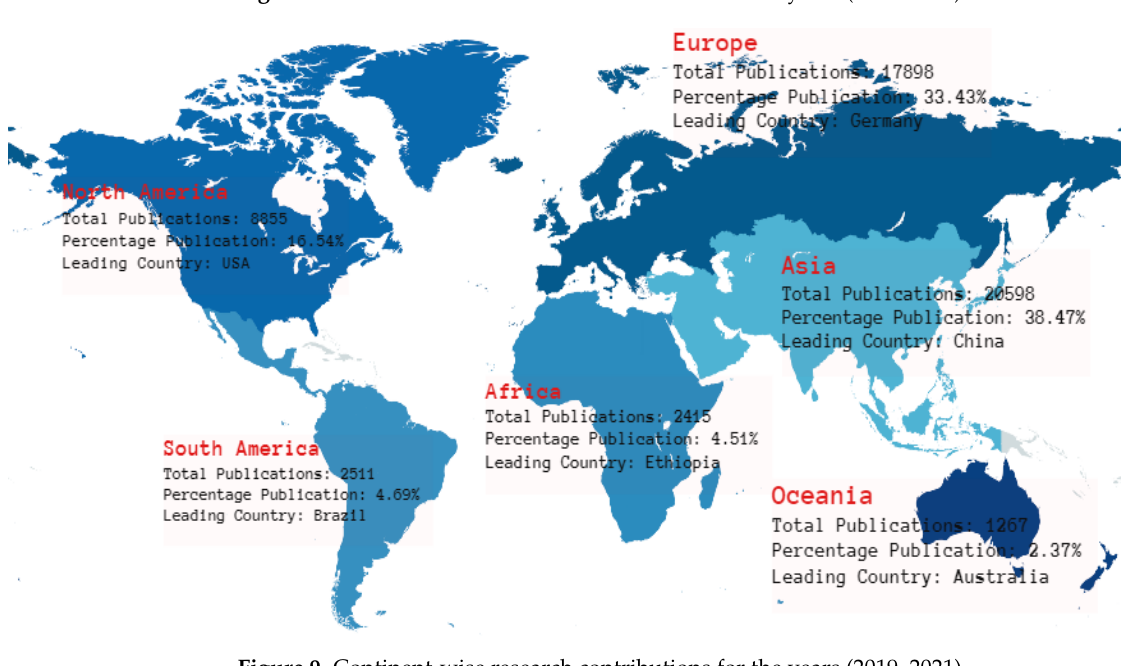
Figure 8. Continent-wise research contributions for the years (2016–2018).